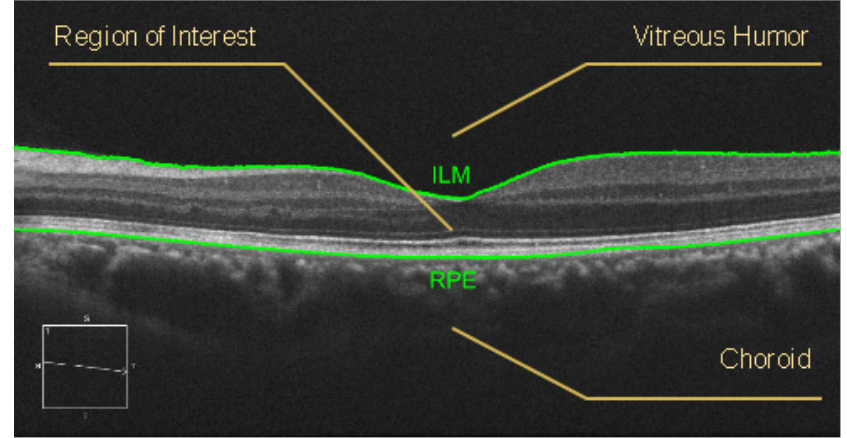
Figure 4. Diagram of the different relevant regions considered in the OCT image: the two limiting layers of the ROI, the vitreous humor and the choroid